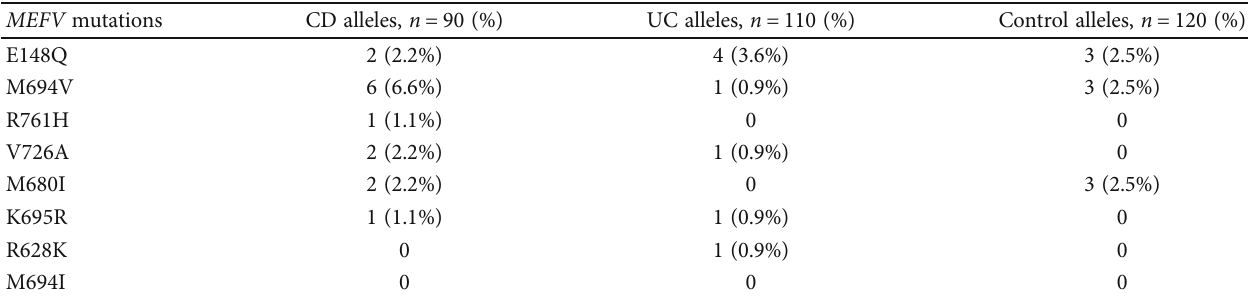
Table 3: Allele frequency of MEFV mutations in patient and control